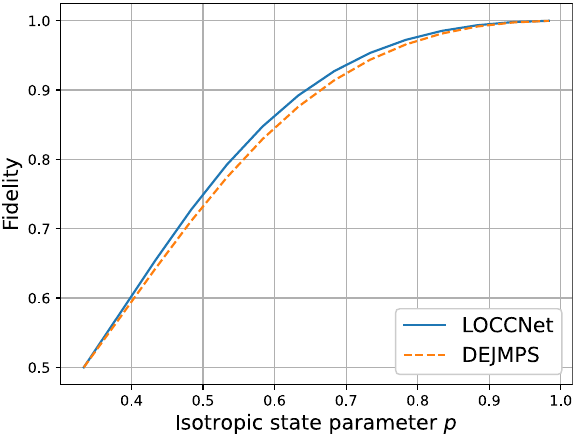
Fig. 5 Fidelity achieved by distillation protocols for four copies of some isotropic state. The blue solid line depicts the fi delity achieved by the protocol learned by LOCCNet, which outperforms the generalized DEJMPS protocol (orange dashed).